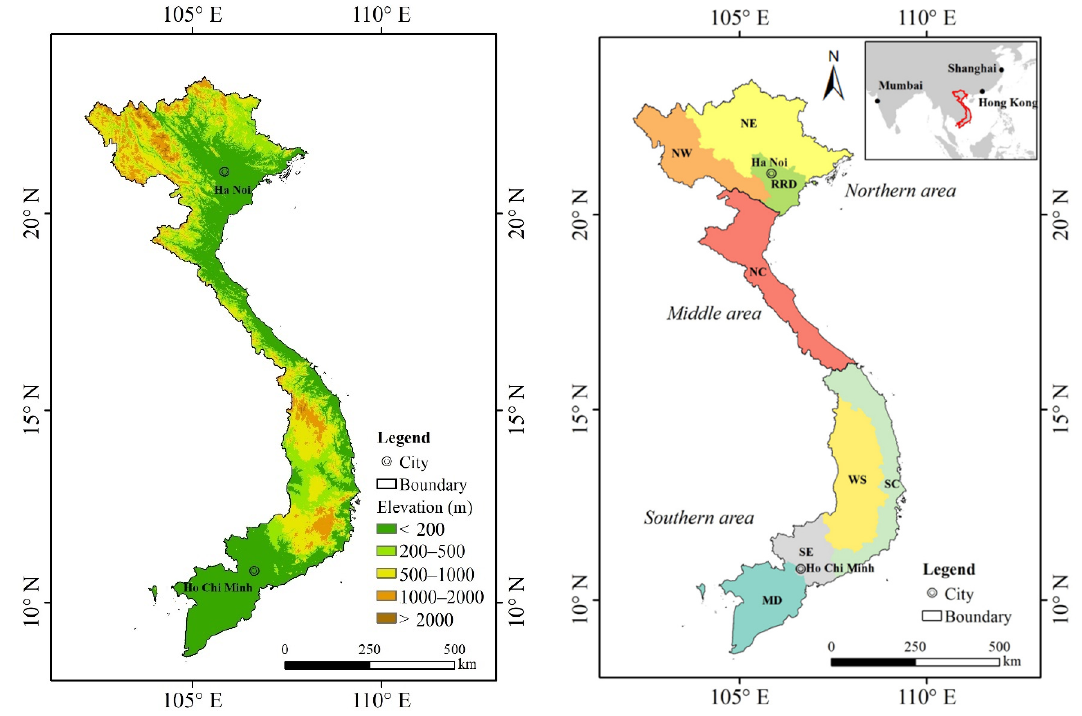
Figure 1. Location, topography and main provinces of Vietnam. The study area has a long and narrow terrain. Three-quarters of the area consists of mountains and plateaus. The northern and northwestern parts are high mountains